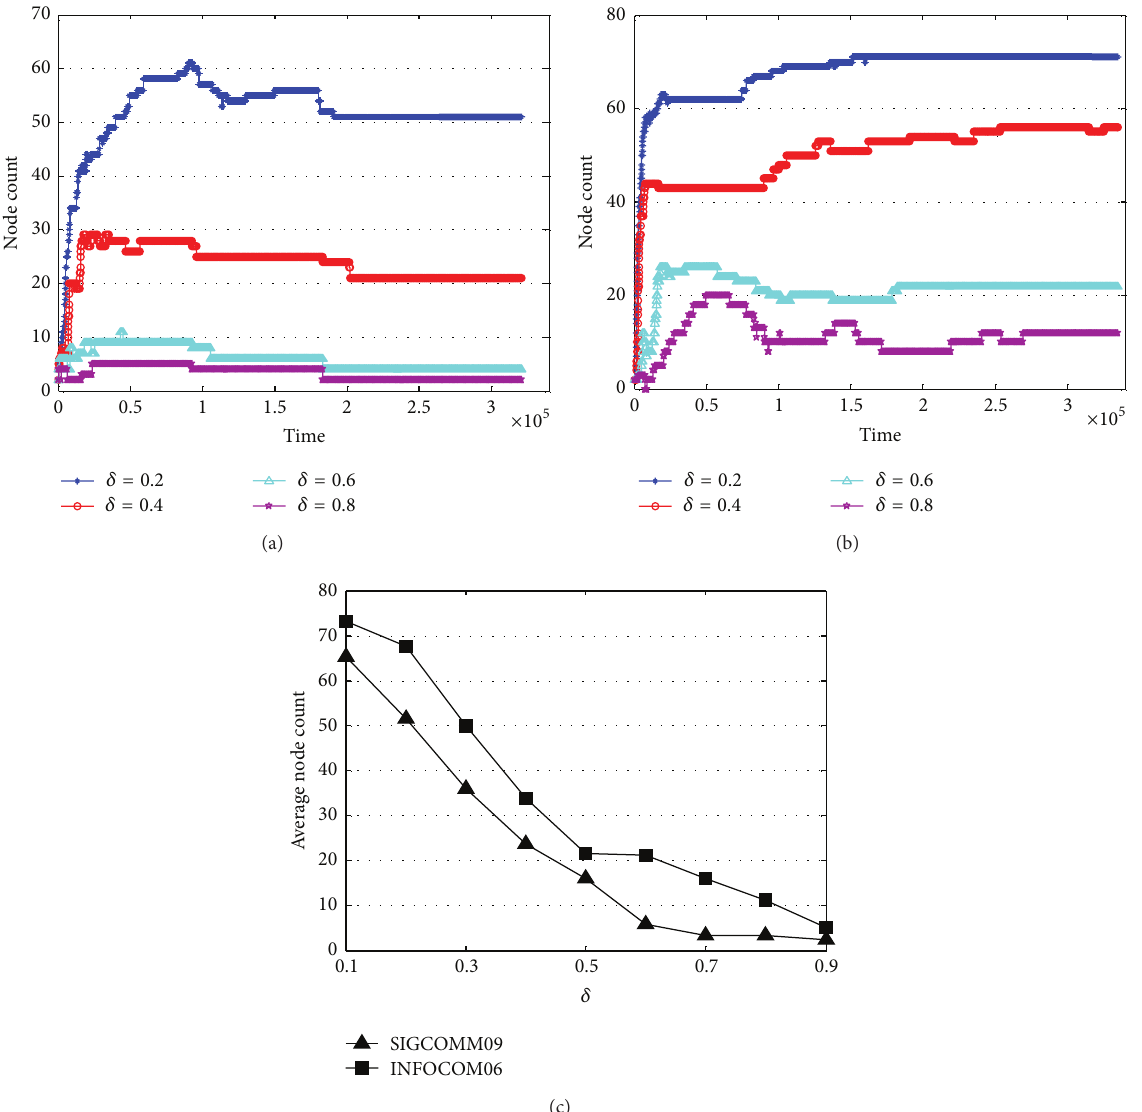
Figure 8: Number of nodes in community core. (a) Variation in number of nodes in community core in SIGCOMM09. (b) Variation in number of nodes in community core in INFOCOM06. (c) Average number of nodes in community core in the two datasets under different 𝛿